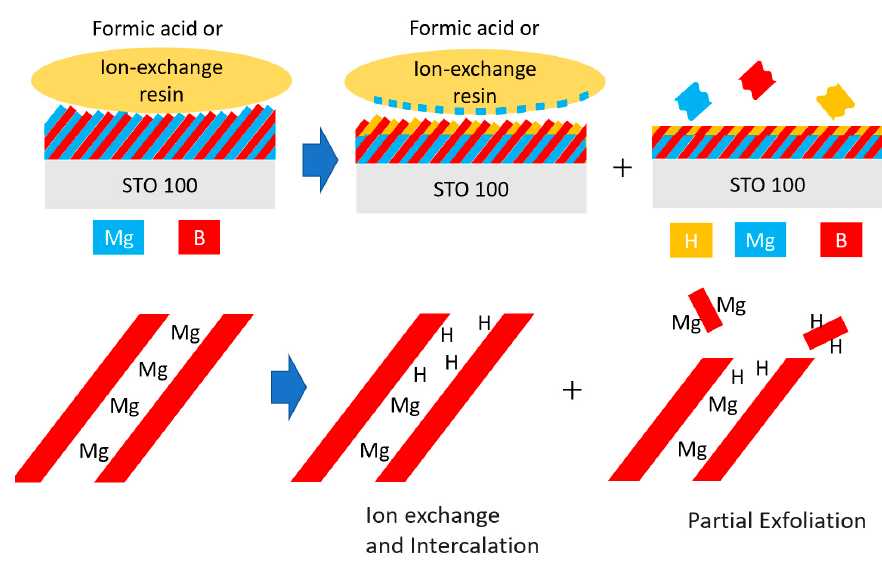
Figure 6. Proposed reaction scheme of the ion-exchange mechanism.